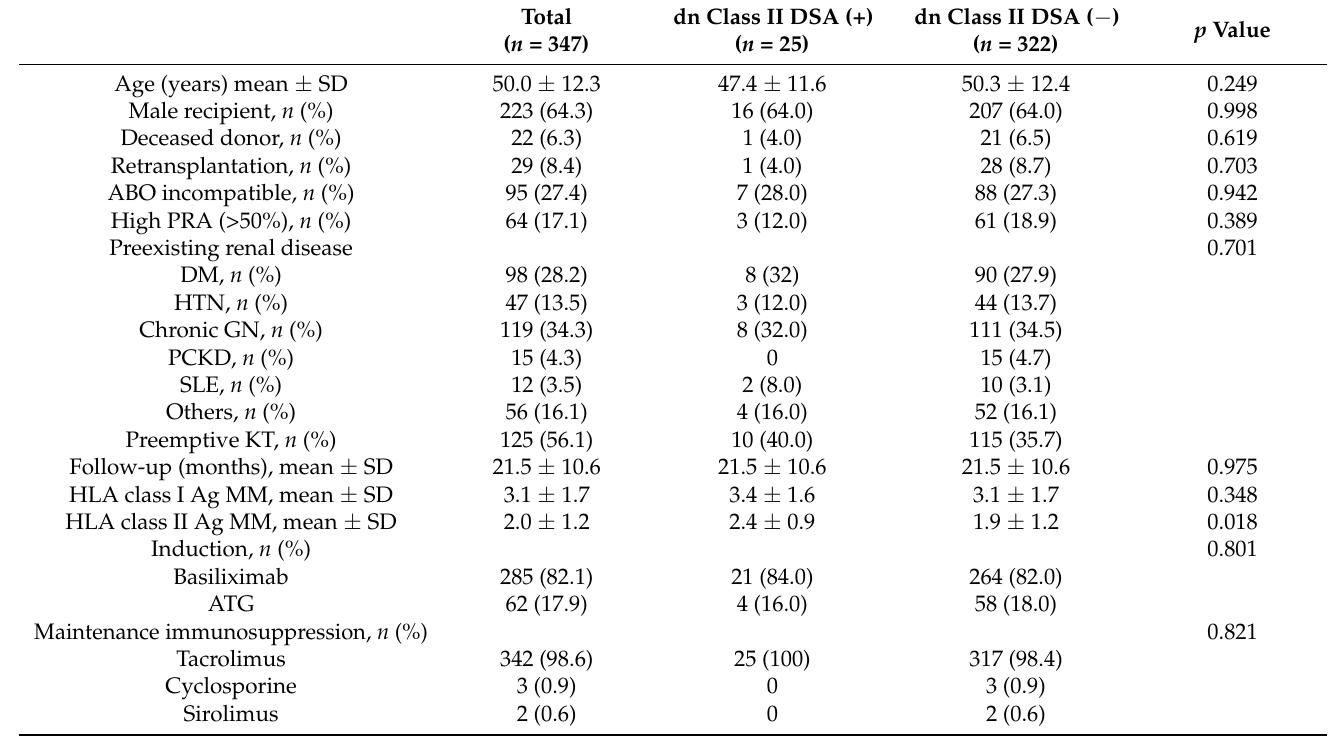
Table 1. Baseline patient demographics.